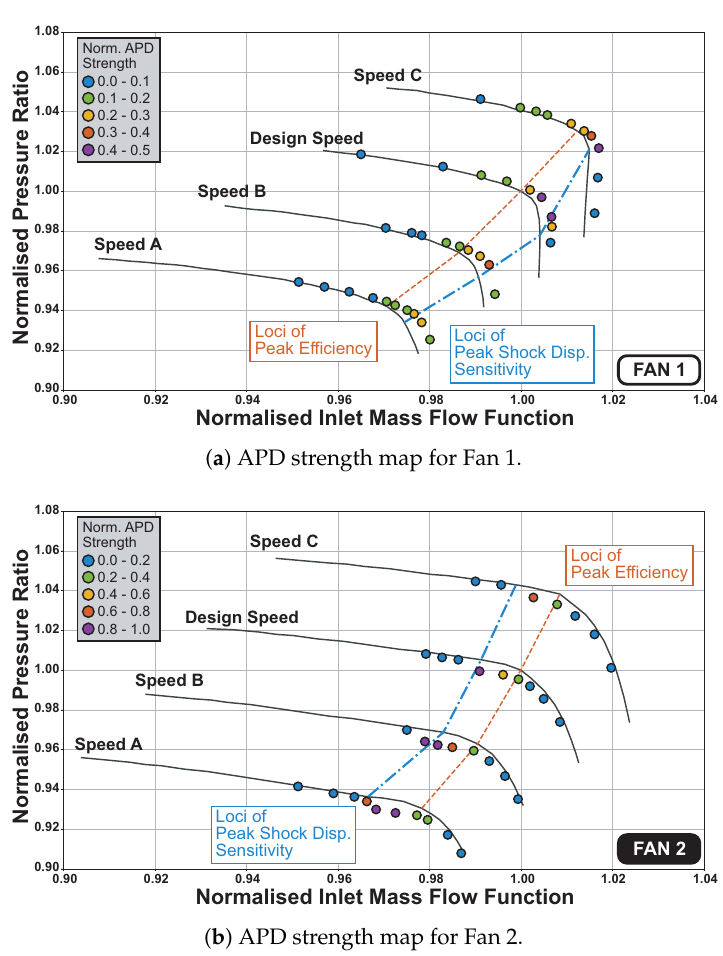
Figure 7. APD strength map